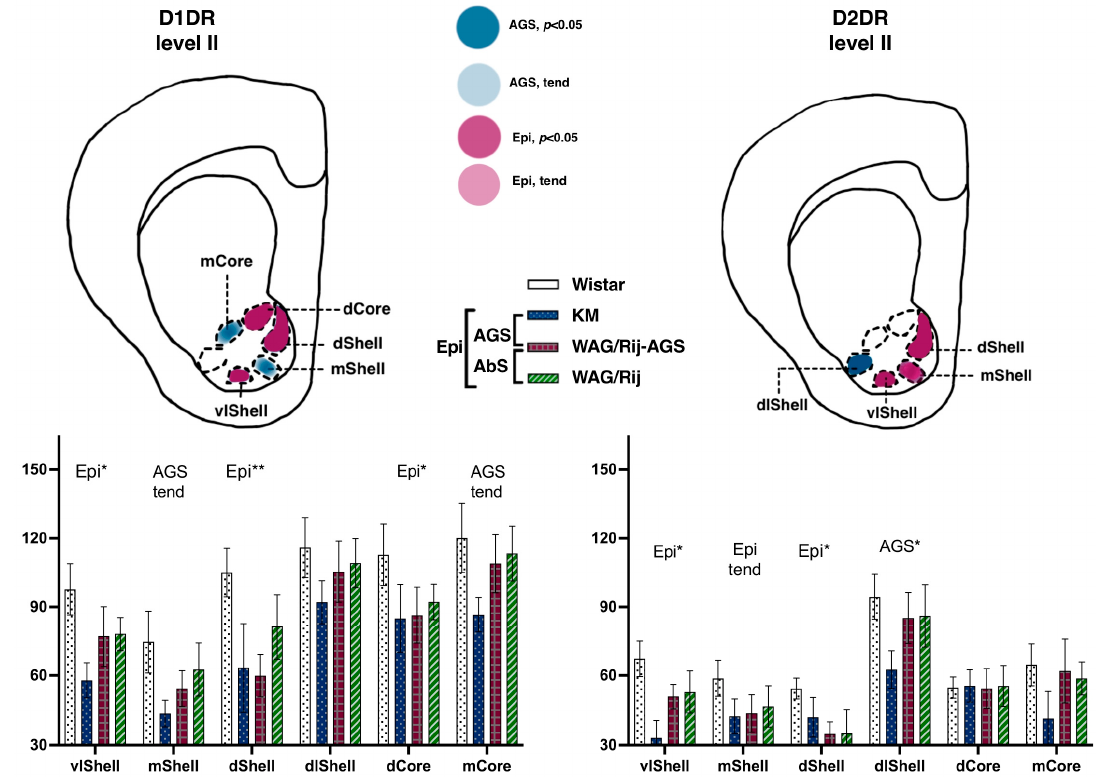
Figure 5. Comparisons of the ventral striatum binding densities to D1DR and D2DR. The values are given as mean ± SEM, in pmol/g of tissue. For anatomical levels and abbreviations, see Figure 3. Differences are shown by stars: * for p ≤ 0.05, ** for p < 0.01, and ‘tend’ sign for tendency (0.05 < p < 0.10). The general effects of epilepsies (a difference between the non-epileptic group and the joint group of all epileptic rats) are marked by ‘Epi’ letters. Effects of audiogenic epilepsy are marked by the ‘AGS’ sign.